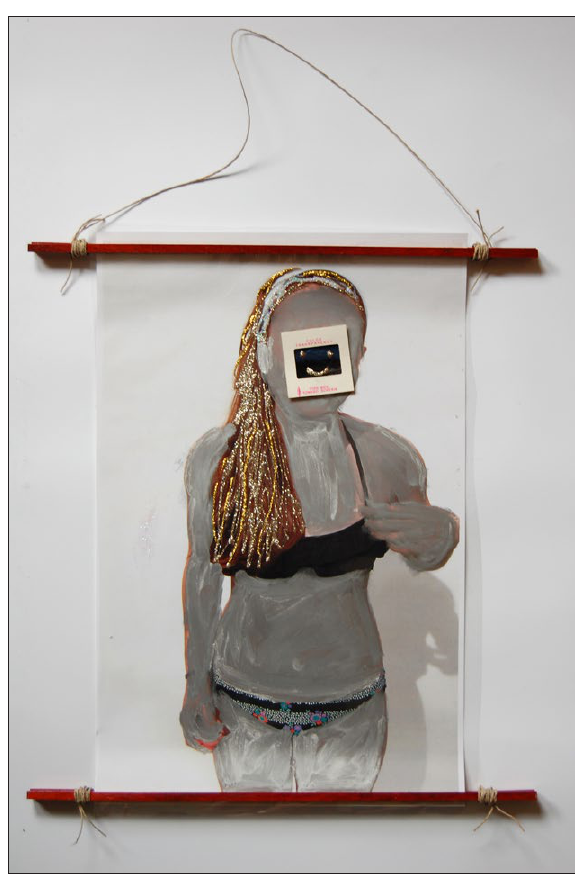
Figure 3: Brain Candy: Bikini,